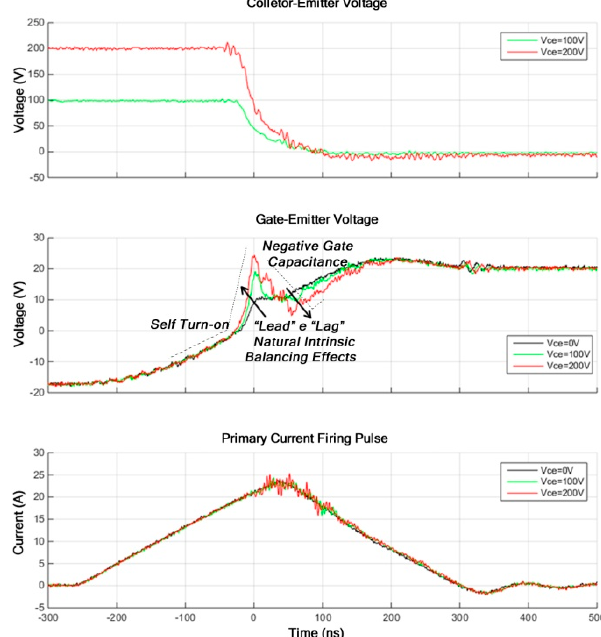
Figure 9. Variation of the gate-emitter voltage during the switching transient for different blocking voltages (0 V, 100 V and 200 V). The “self-turn-on" and "negative gate capacitance" physical effects were identified, resulting in the natural intrinsic balancing of the collector-emitter voltage.